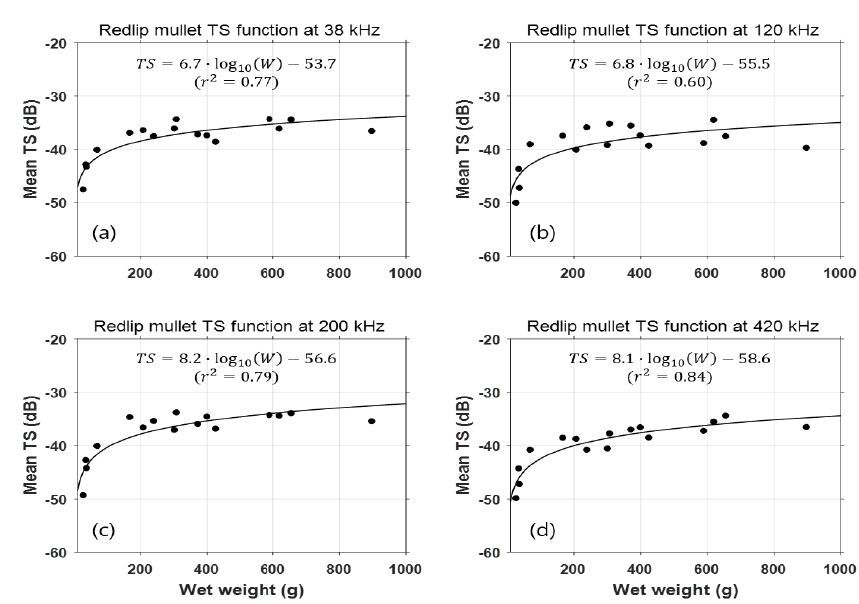
Figure 6. Relationship between the target strength ( TS ) and wet weight ( W ) at ( a ) 38, ( b ) 120, ( c ) 200, and ( d ) 420 kHz. Points represent the mean TS values, and solid lines represent least-squares regressions of mean TS .